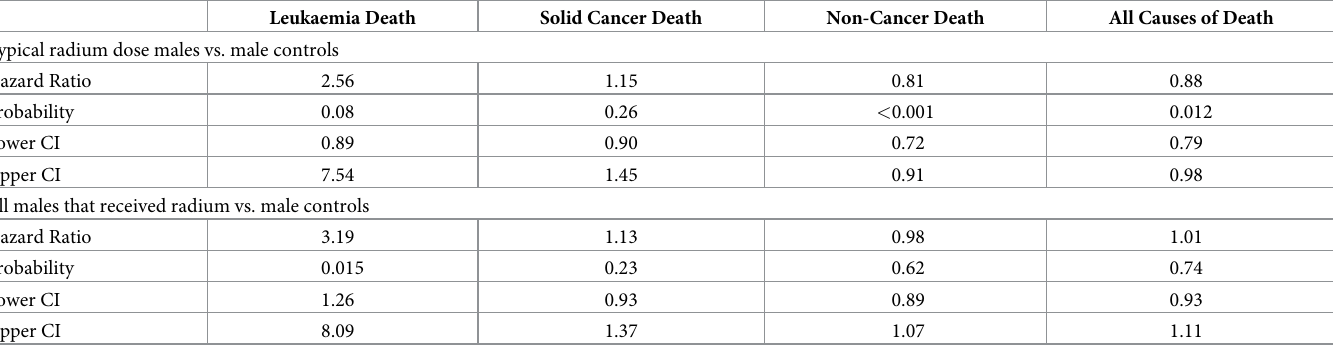
Table 1. The calculated hazard ratios, p values and 95% confidence intervals for cancer and non-cancer deaths in the male radium patients injected 224 Ra compared to controls. Leukaemia Death Solid Cancer Death Non-Cancer Death All Causes of